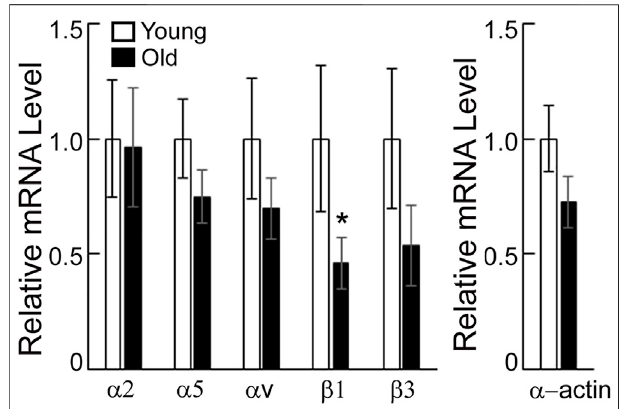
FIGURE 2 | PCR assays were performed on VSM cells isolated from youngandoldSFA.RelativemRNAexpressionlevelsfromyoungandoldVSM cells were expressed relative to young VSM cells for each gene. Data are shownasmean±SD( n =3-4animals).Signi fi cancewasevaluatedat p < 0.05. *Values are signi fi cantly different from